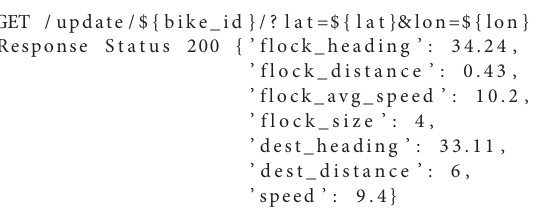
flocks will change according to availability of concurrent users with similar